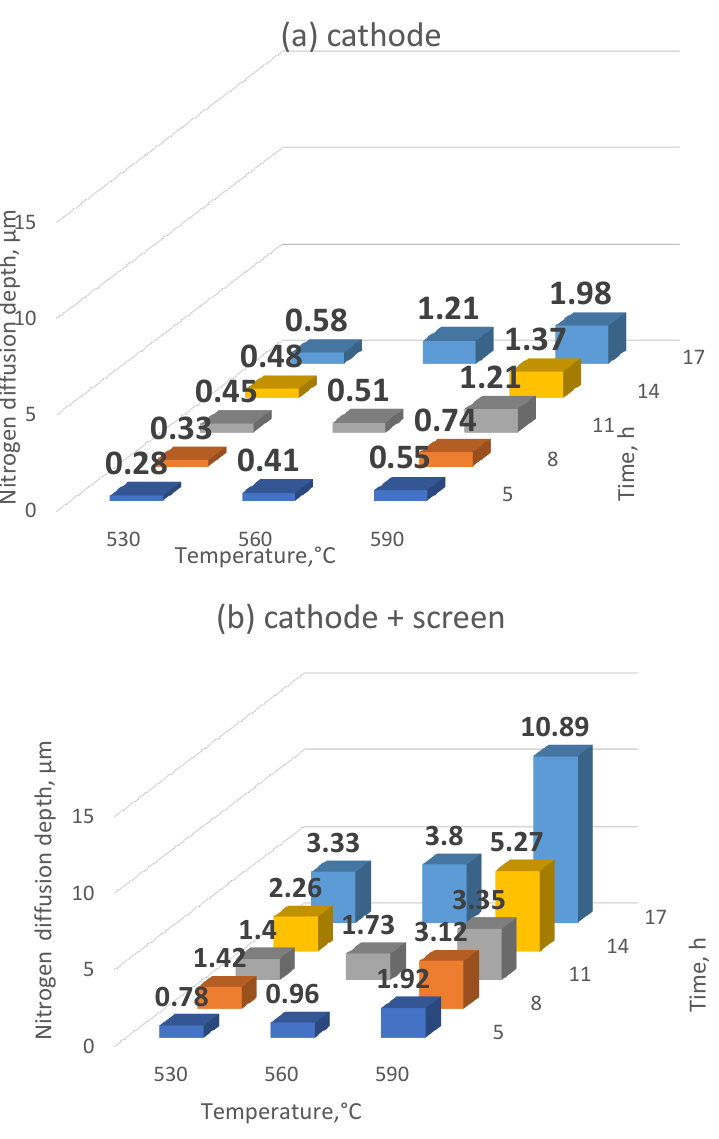
Figure 7. The depth of nitrided layers on the substrate of Grade 5 titanium alloy depending on the position of the samples in the glow chamber: ( a ) cathode, ( b ) cathode + screen.